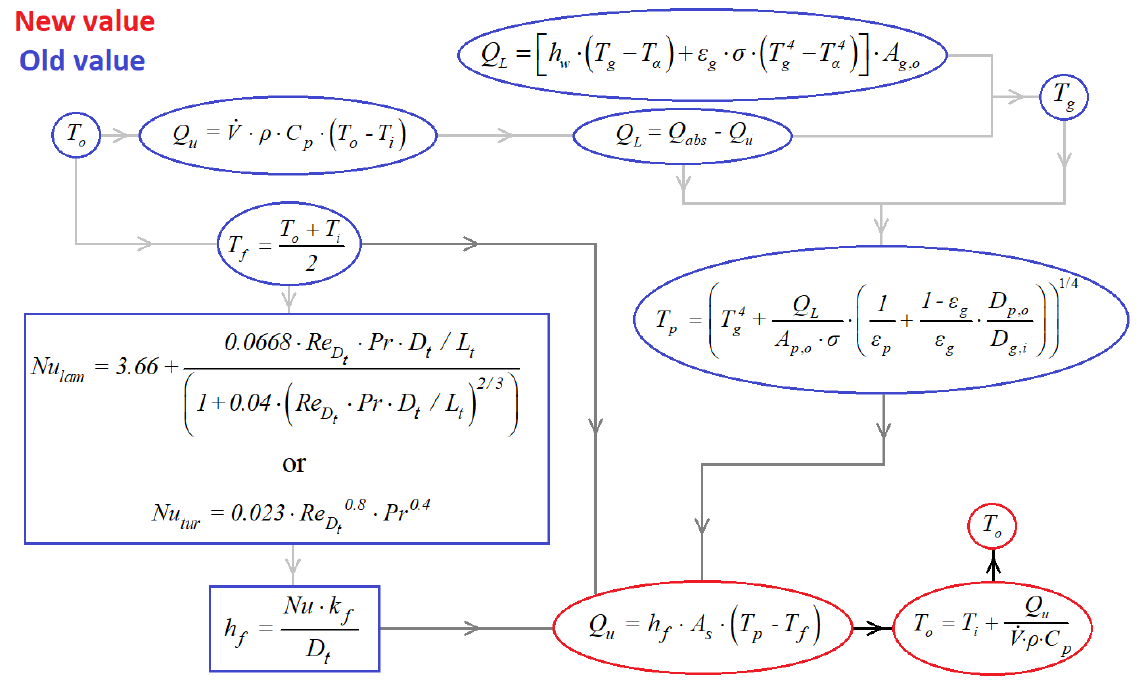
Figure 3. Analytical approach flow chart.